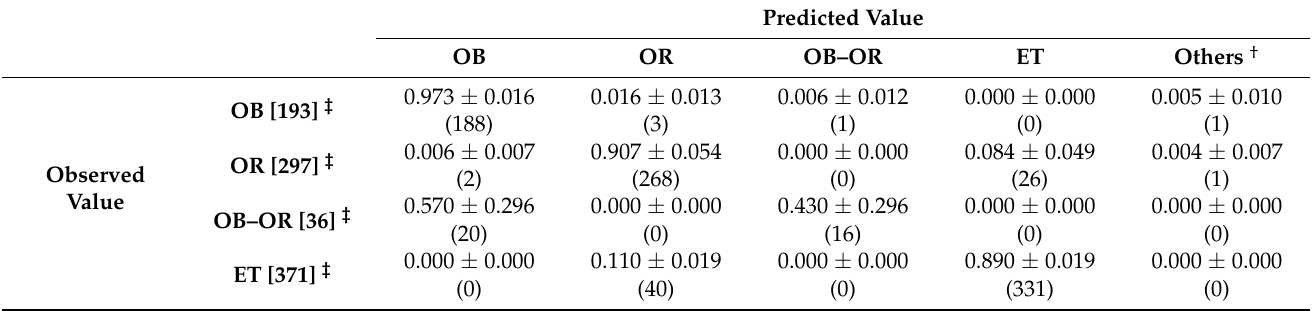
Table 4. Mean values and standard deviations of the normalized confusion matrices over five cross-validation runs. Values in the parentheses represent the confusion matrix calculated with the combined data of the test sets of five-fold cross validation runs for three-label